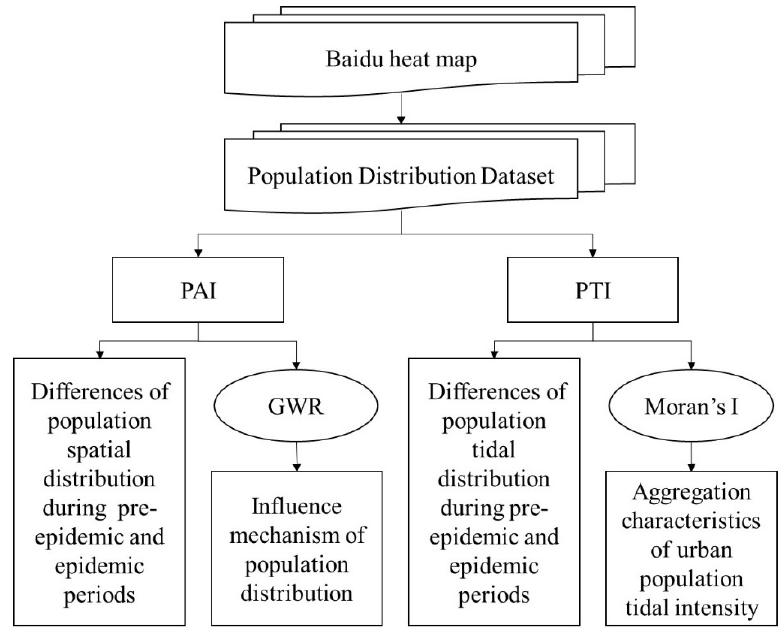
Figure 2. Technology roadmap.